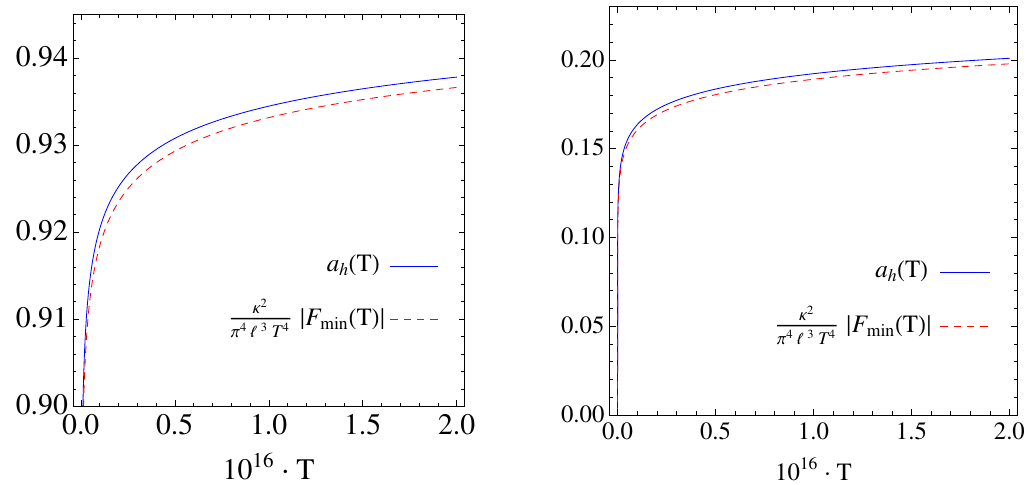
Figure 3 . The quantities a h ( T ) (blue solid line) and (cid:20) 2 F min = ( (cid:25) 4 ‘ 3 T 4 ) (red dashed line) as a function of T in the scenarios of the class A (left panel) and class B (right